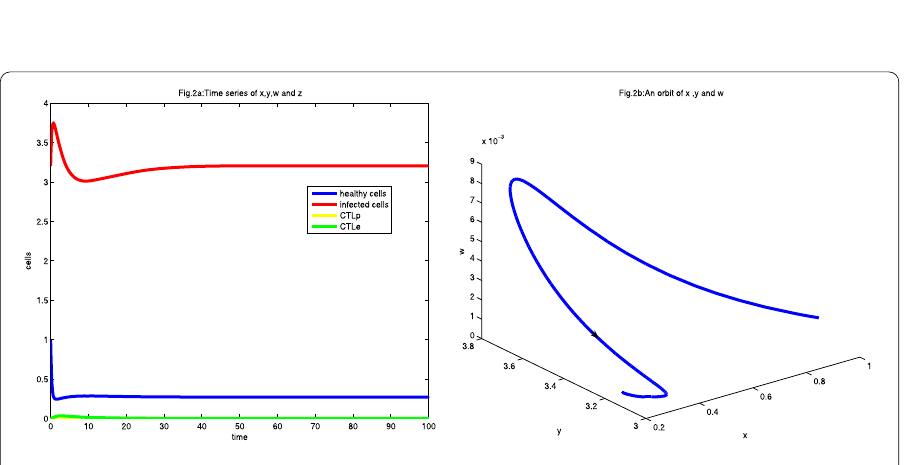
Figure 2 Figure 2( a ) is the diagram of time series of x , y , w , and z at a = 0.27 with initial value (1,3.2,0.001,0.002). Figure 2( b ) is the phase diagram of x , y , and z with the same initial